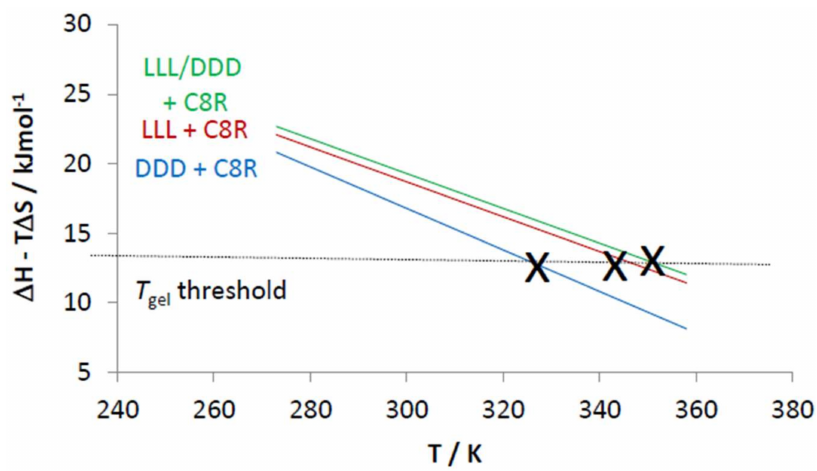
Figure 8. Plot of ∆ H − T ∆ S against temperature using the data from Table 5. X’s mark the experimental T gel values reported in Table 4. This graph highlights the differences between systems and the apparent existence of a T gel threshold.